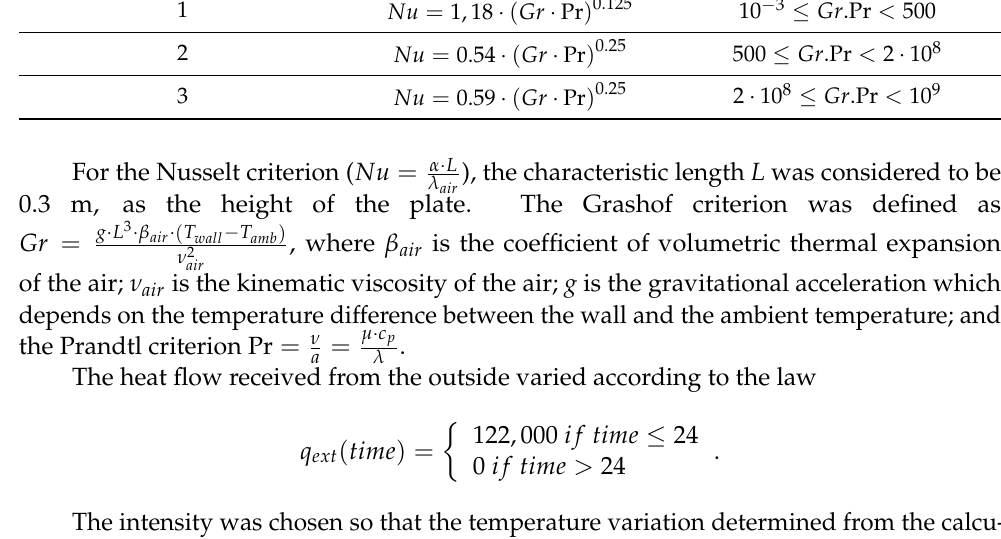
Table 1. The calculation relationships. The Nusselt Criterion (Nu) Conditions